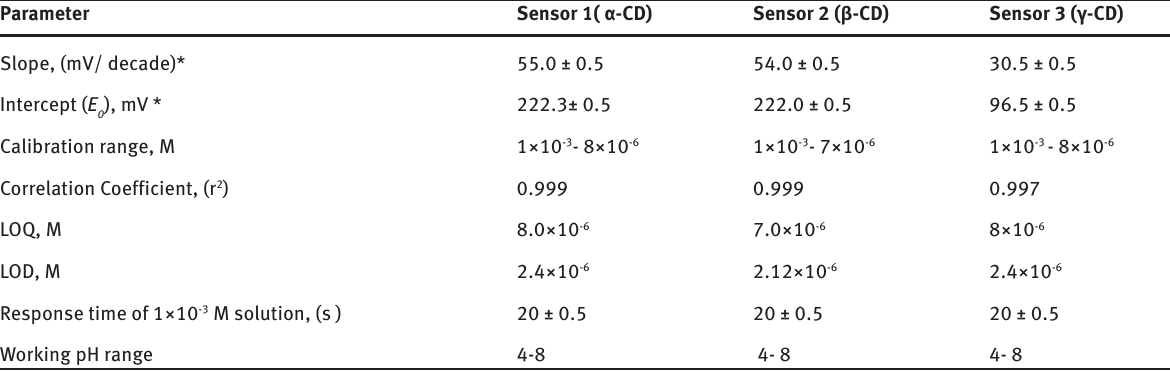
Table 2: Analytical characteristics of the procainamide sensors. Parameter